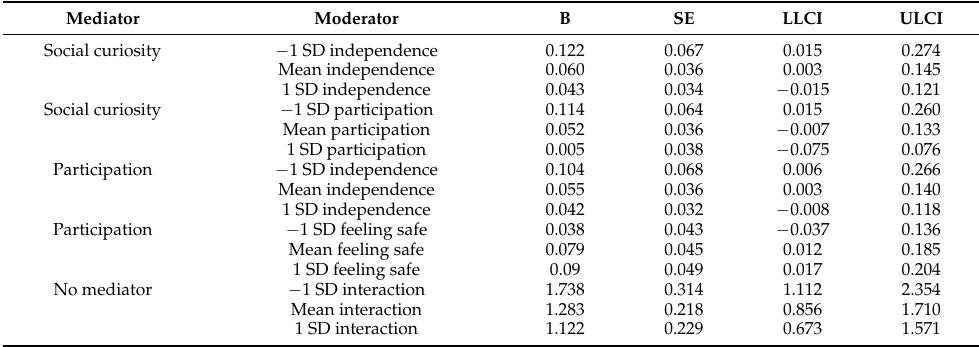
Table 6. Conditional indirect effects and conditional effects of loneliness on depression symptoms at values of multifaceted social